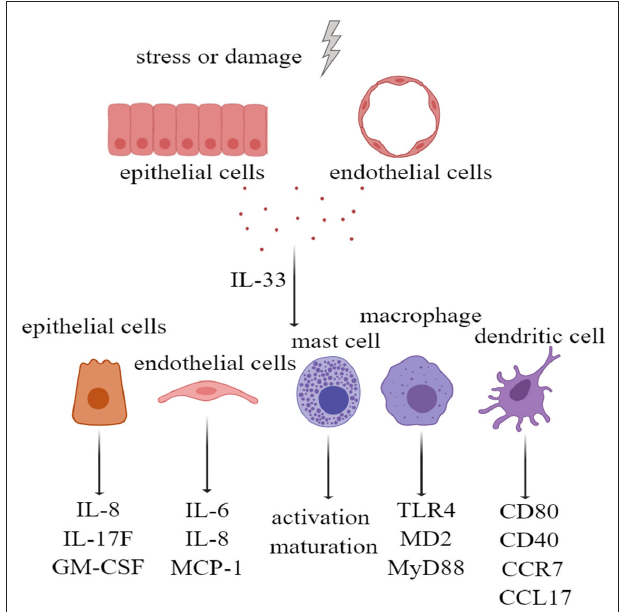
FIGURE 1 | Physiological function and activity regulation of interleukin-33 (IL-33). IL-33 firstly binds to its transmembrane receptor serum stimulation-2 (ST2) to induce conformational changes; then ST2 interacts with IL-1RAcP and recruits the downstream adaptor MyD88, IRAK1, IRAK4, and TRAF6 via Toll/IL-1 receptor domains; and ultimately activates nuclear factor-kappa B (NF- κ B) and mitogen-activated protein kinases (ERK, p38, and JNK). This signal pathway can also be inhibited by phosphorylation and ubiquitylation of ST2 and SIGIRR, which disrupt ST2 and IL-1RAcP dimerization. Several mechanisms are involved to regulate the activity of IL-33. Processing by inflammatory proteases can greatly increase (up to 30-fold) cytokine activity, while caspase-3 and caspase-7 lead to cytokine inactivity. Decoy receptor soluble ST2 (sST2) and rapid oxidation of IL-33 are also crucial mechanisms to limit the activity of IL-33. SIGIRR, single immunoglobulin domain IL-1 receptor-related molecule; IRAK, IL-1R-associated kinase; TRAF6, TNF